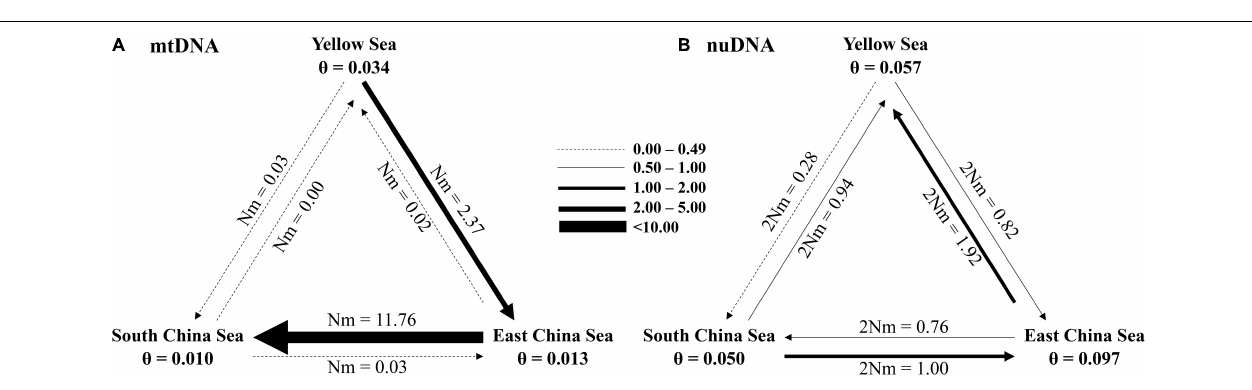
FIGURE 8 | Number of migrants (per generation, Nm) among Tridentiger bifasciatus metapopulations from the Yellow Sea, East China Sea, and the South China Sea, and their effective population sizes ( θ ) based on (A) mtDNA and (B)